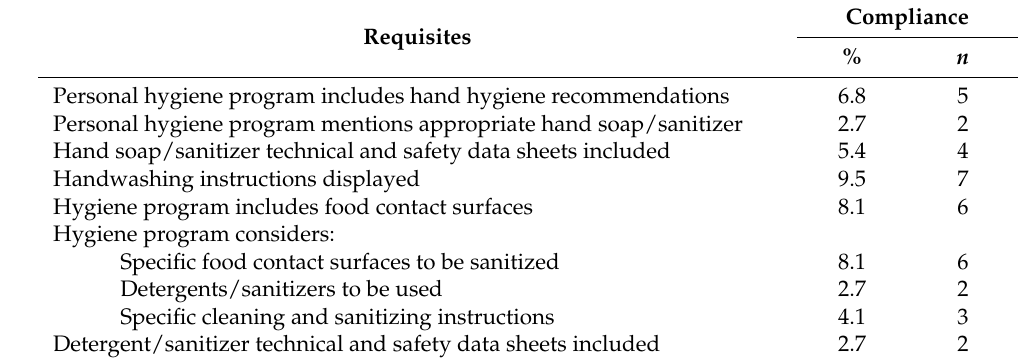
Table 3. Documental assessment of hand hygiene and food contact surfaces hygiene procedures compliance